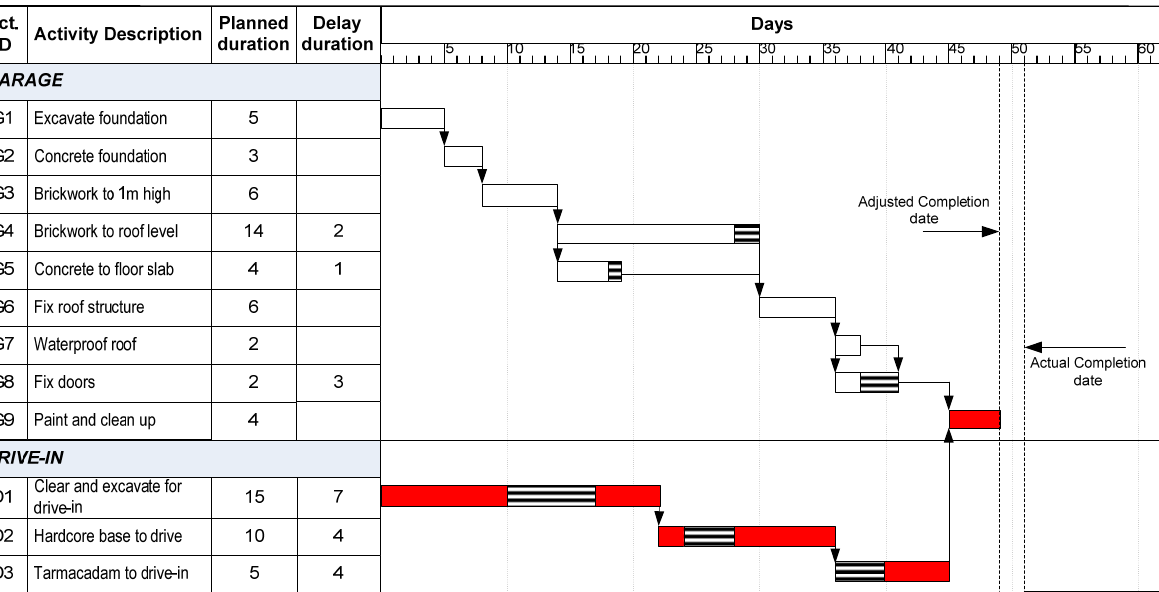
Figure 15. As-planned schedule impacted with owner’s